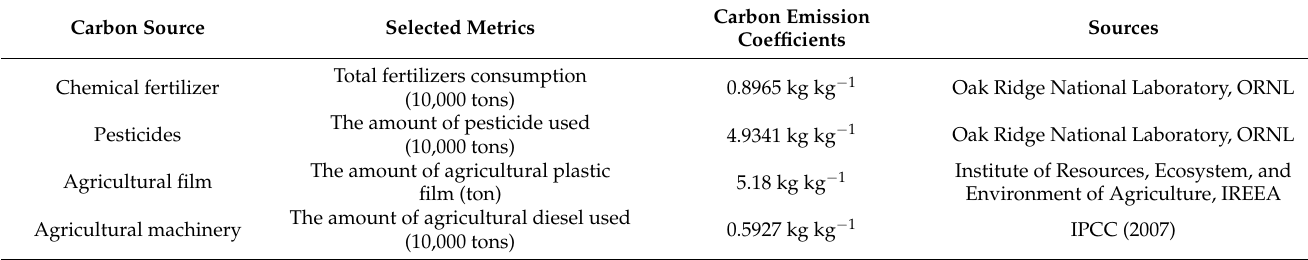
Table 2. Carbon emission coefficients of different input elements in the agricultural production